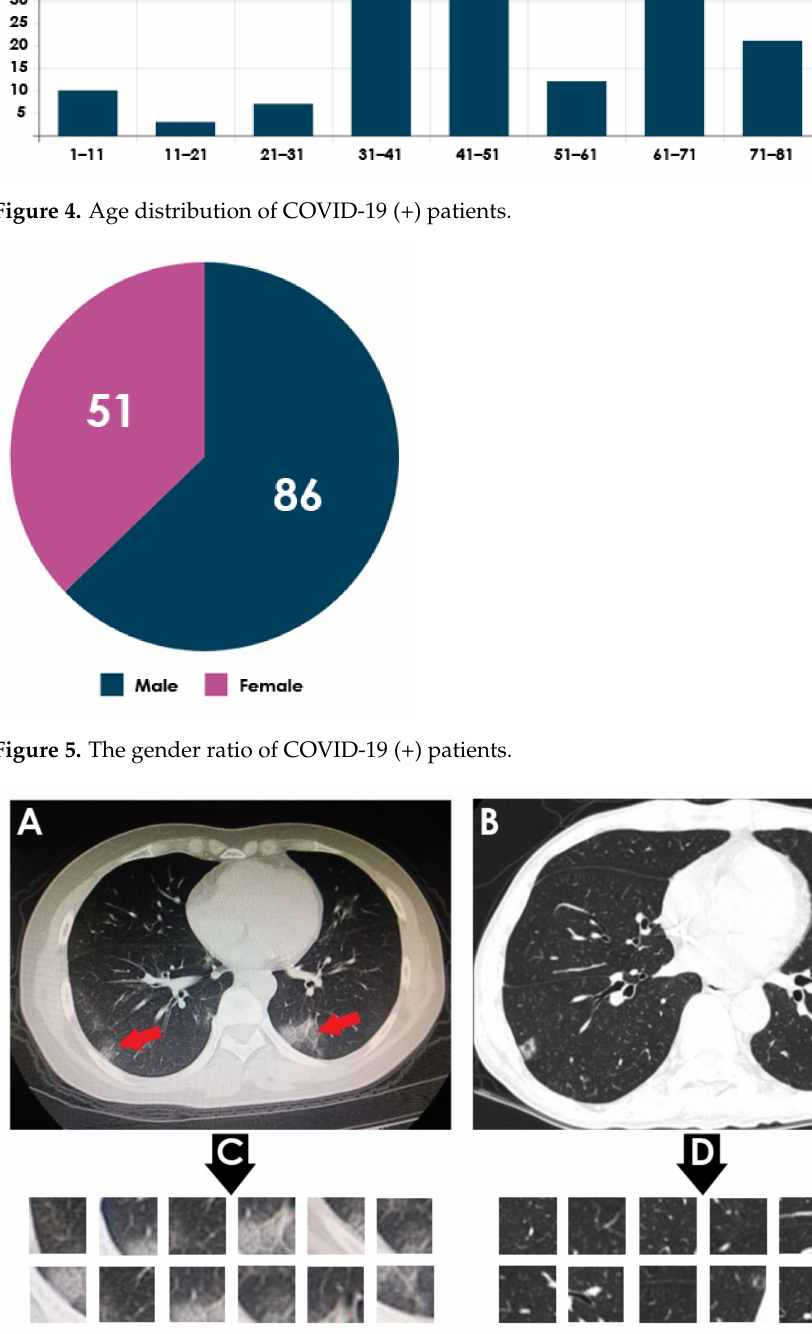
Figure 6. ( A ) Shows a CT of the lungs of COVID-19 (+) patient, in which there are multiple patchy ground-glass opacities in bilateral subpleural areas indicated by red arrows. ( B ) Represents a CT of the lungs of a COVID-19 ( − ) patient with normal controls. ( C ) Depicts infected patch samples. ( D ) Reflects non-infected patch samples. COVID-CT dataset [22] is the source for these